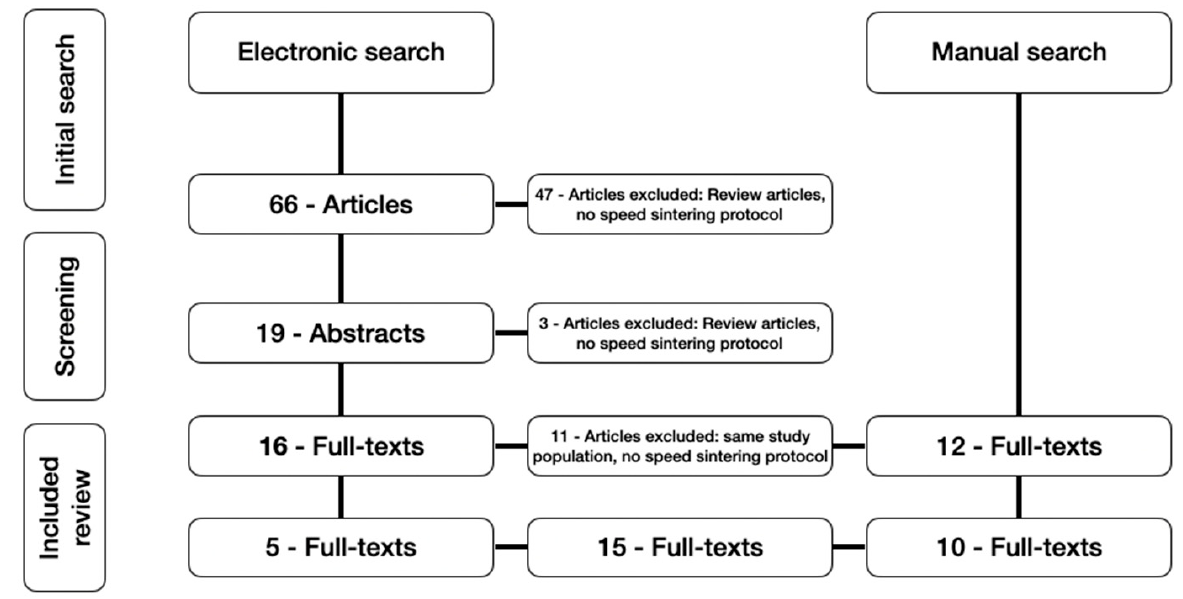
Figure 1. Systematic search results illustrated as a Flow